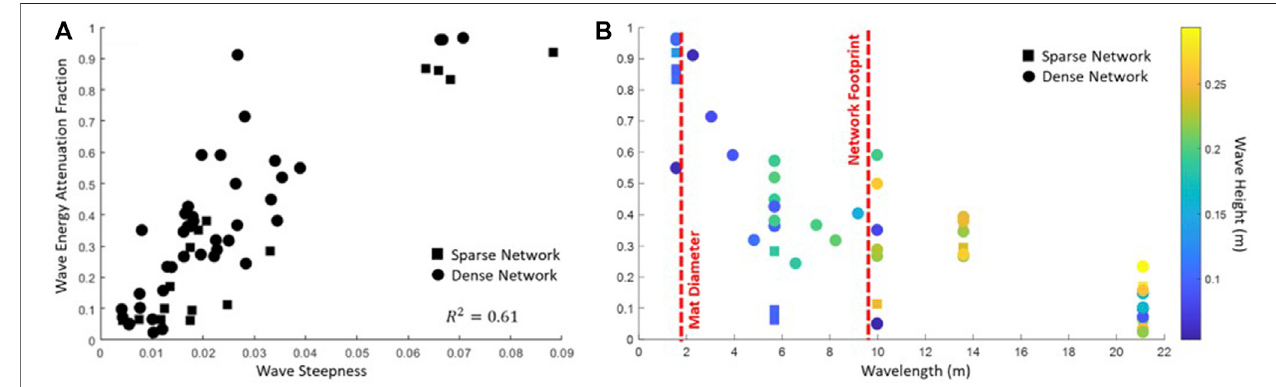
FIGURE 7 | (A) Wave steepness (x-axis) versus wave attenuation (y-axis) where 0 is no attenuation and 1 is full attenuation. Symbols represent the network con fi guration (square is sparse, circles are dense). (B) Wavelength (x-axis) versus wave attenuation (y-axis). Color indicates wave height (yellow is higher, blue is lower) and symbol represents the network con fi guration (square is sparse, circles are dense). The red dotted lines indicate the size of the mat diameter and of the network footprint in the direction of wave propagation (speci fi cally for the dense network con fi guration).